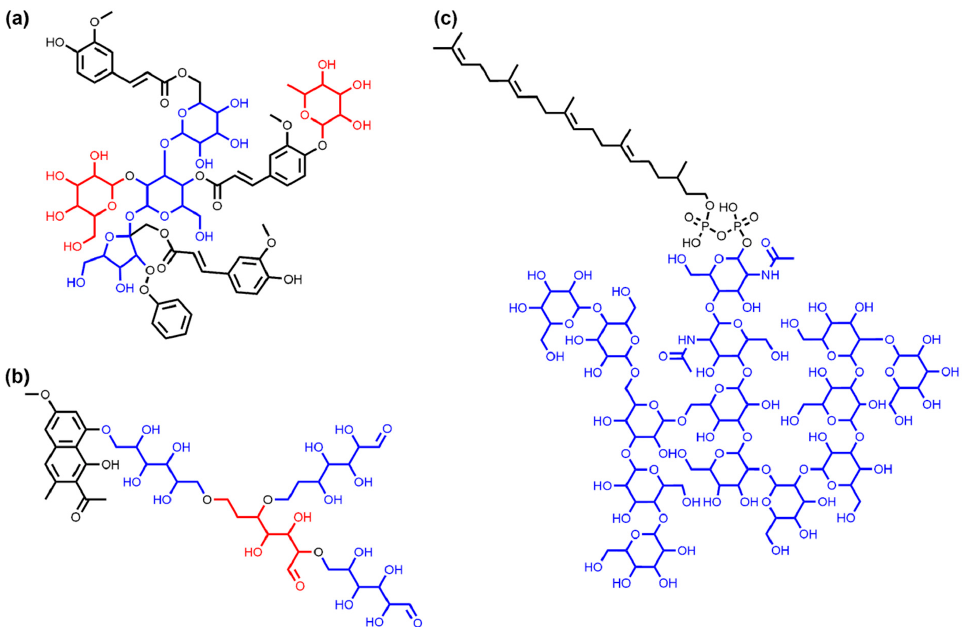
Figure 8. Examples of NPs with several circular or linear sugar moieties. ( a ) Dalmaisiose P (COCONUT ID CNP0319224), an oligosaccharide with five terminal (in red) and non-terminal (in blue) circular glycosidic moieties. ( b ) COCONUT molecule CNP0309951, the NPs in COCONUT with the most identified linear sugar moieties (coloured in red and blue only to mark the four distinct moieties, all of them are terminal). ( c ) Glycan G00008 (CNP0083402), a dolichyl diphosphooligosaccharide that is one of three NPs in COCONUT with the most (14 in total) identified circular sugar